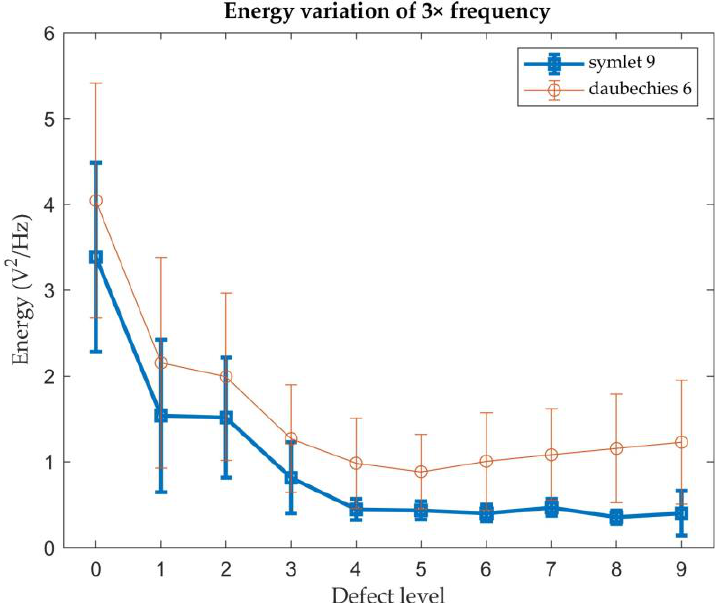
Figure 7. Energy variation of 3× frequency using Symlet 9 and Daubechies 6.